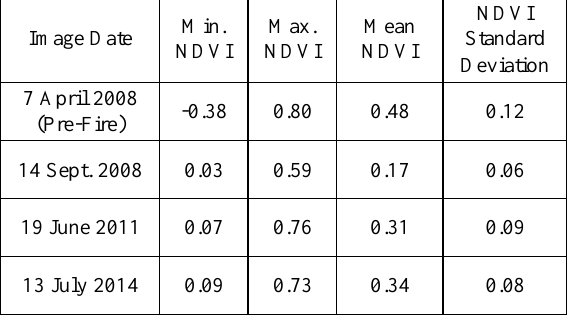
Table 2. Multitemporal NDVI statistics